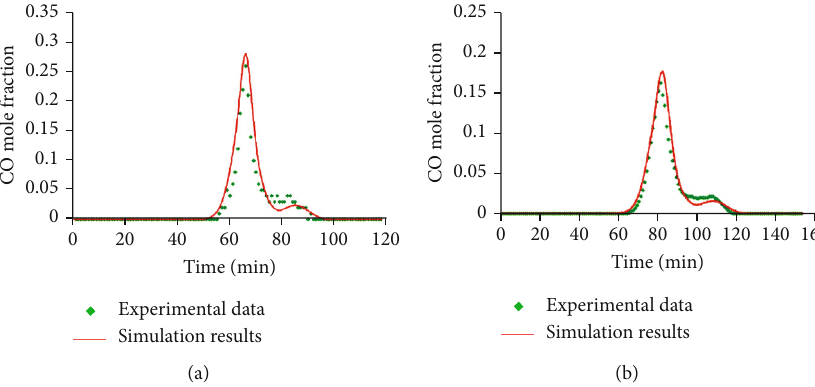
Figure 9: (a) CO production history match for the kinetic cell (RTO) experiments with heating rates of 5.22 ° C/min; (b) CO production history match for the kinetic cell (RTO) experiments with heating rates of 3.22 ° C/min.